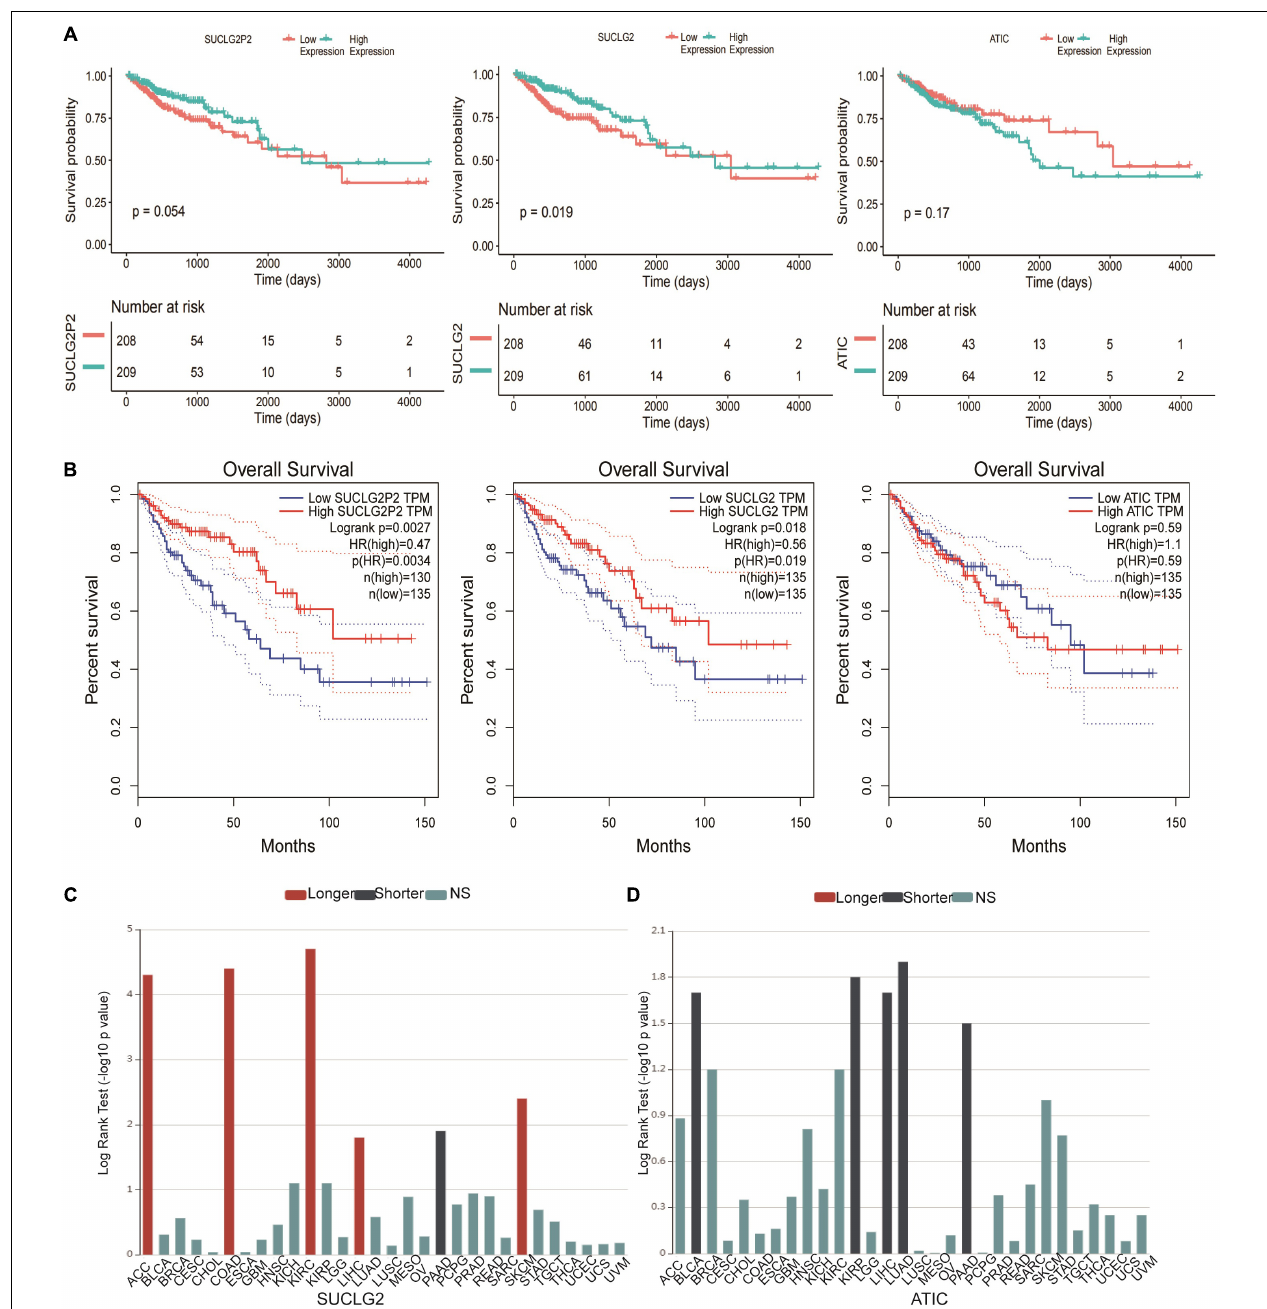
FIGURE 4 | Survival analyses of SUCLG2P2, SUCLG2 and ATIC expression from public Database. (A) Kaplan–Meier survival curves comparing the high and low expression of three genes in COAD from TCGA downloaded data. (B) Kaplan–Meier survival curves from GEPIA database. (C) Kaplan–Meier survival curves of SUCLG2 in different types of cancer in the TISIDB database. (D) Kaplan–Meier survival curves of ATIC in different types of cancer in the TISIDB database. Longer represented longer survival time, Shorter represented shorter survival time, NS represented no statistical